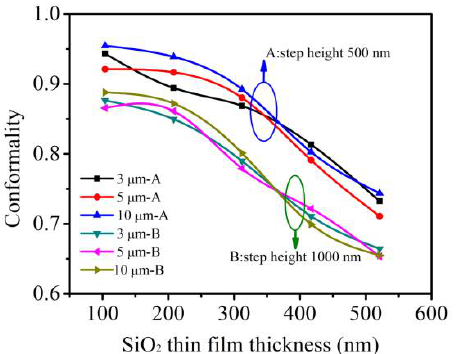
Figure 7. Conformality as functions of the SiO 2 thin film thickness.